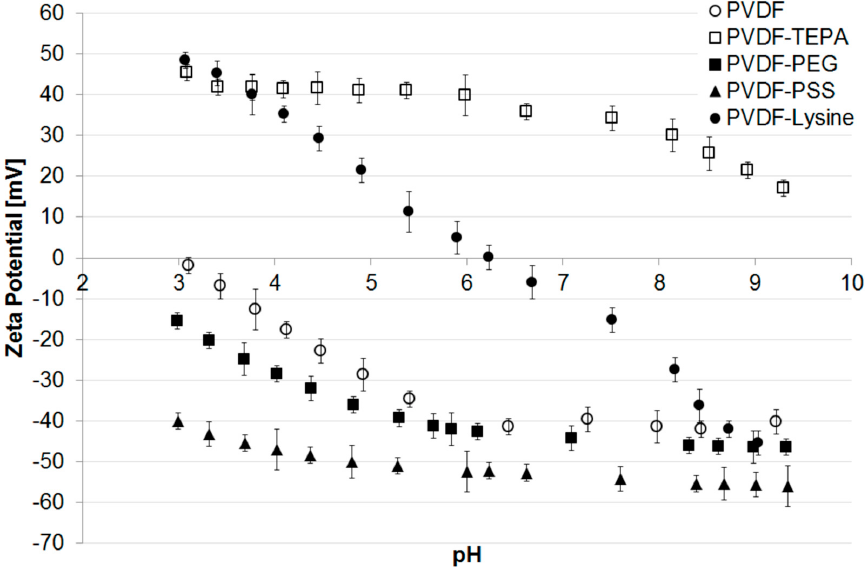
Figure 3. Zeta potential of different modified membranes vs. pH.